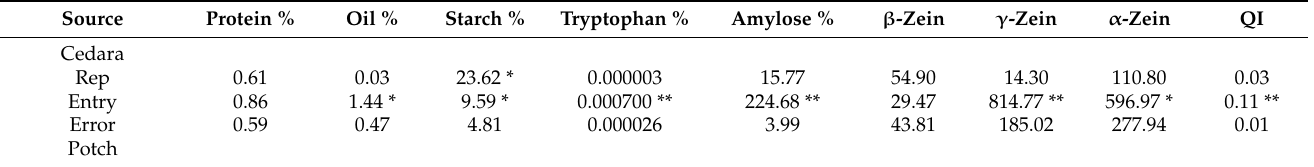
Table 2. Analysis of variance of quality traits analysed for 40 inbred lines at four environments in Zimbabwe and South Africa during the 2017/2018 cropping